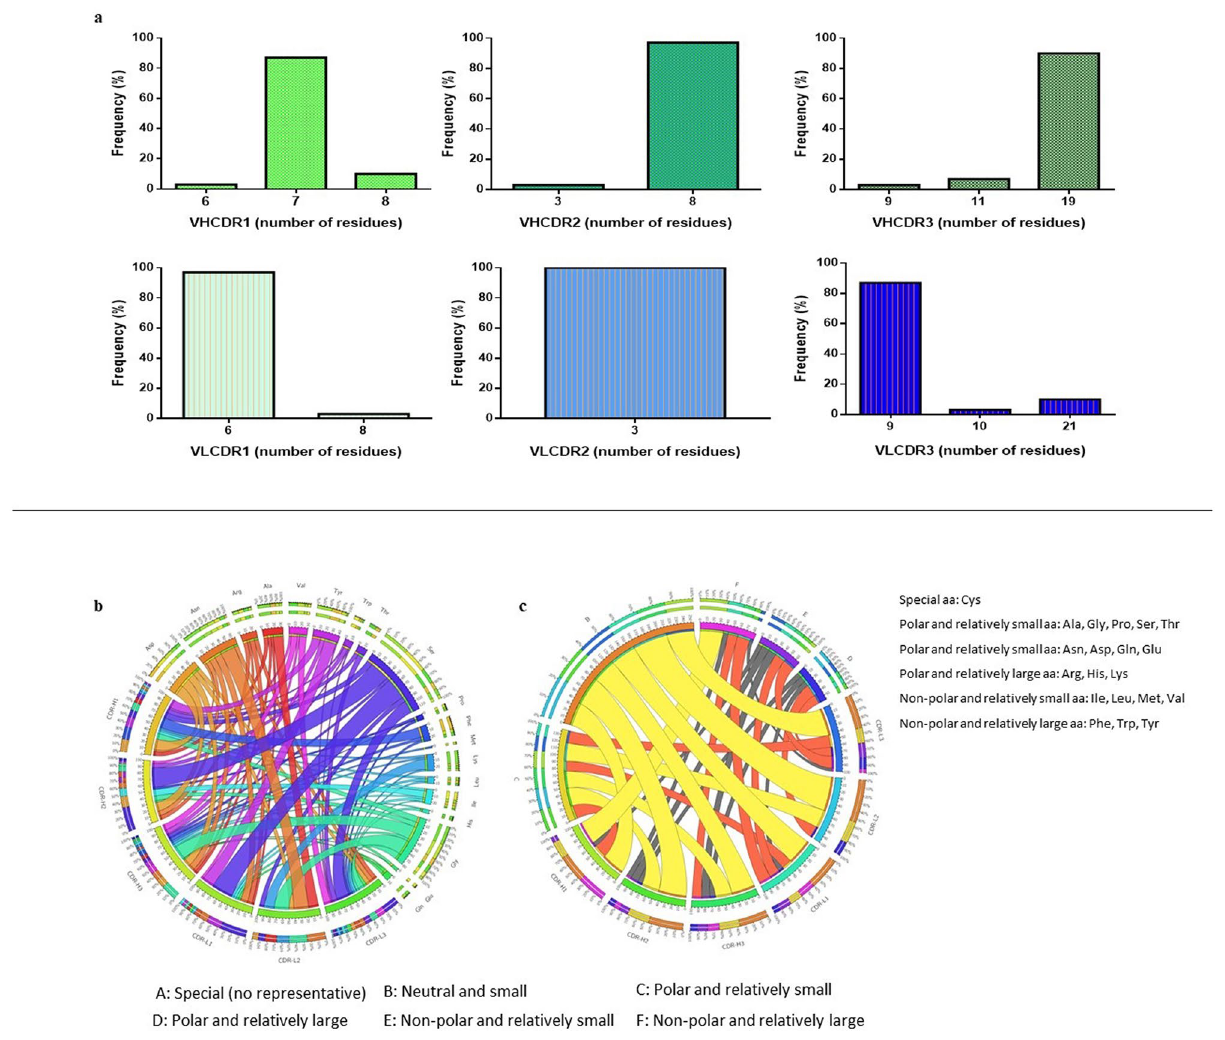
Figure 3. Monoclonal antibody clone characterization. ( a ) Amino acid length variations of heavy and light chains of antibody clones. ( b ) CIRCOS diagram analysis for amino acid frequency. ( c ) CIRCOS diagram analysis for amino acid polarity. CIRCOS diagrams were drawn using Circos Table Viewer v0.63–9 (http://mkweb .bcgsc .ca/table viewe r/visua